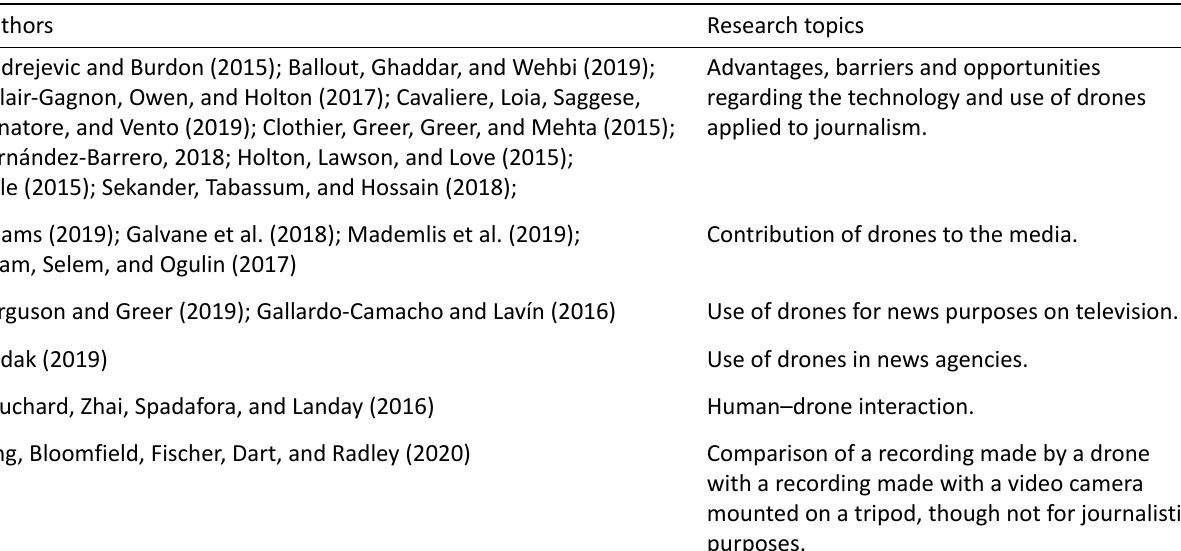
Table 1. Scientific literature on drone